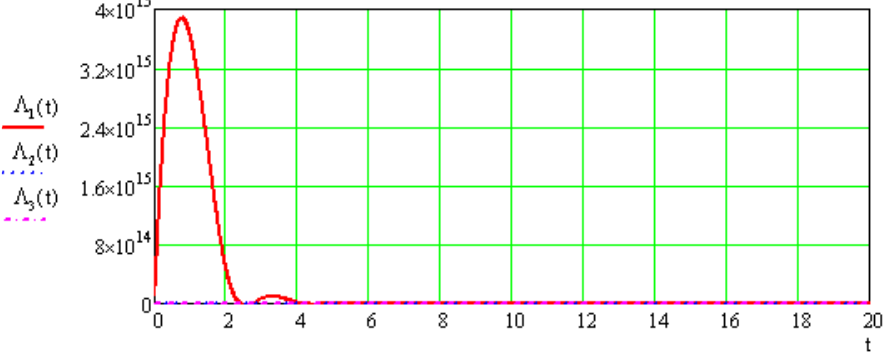
Figure 4. Program functions in the third iteration.